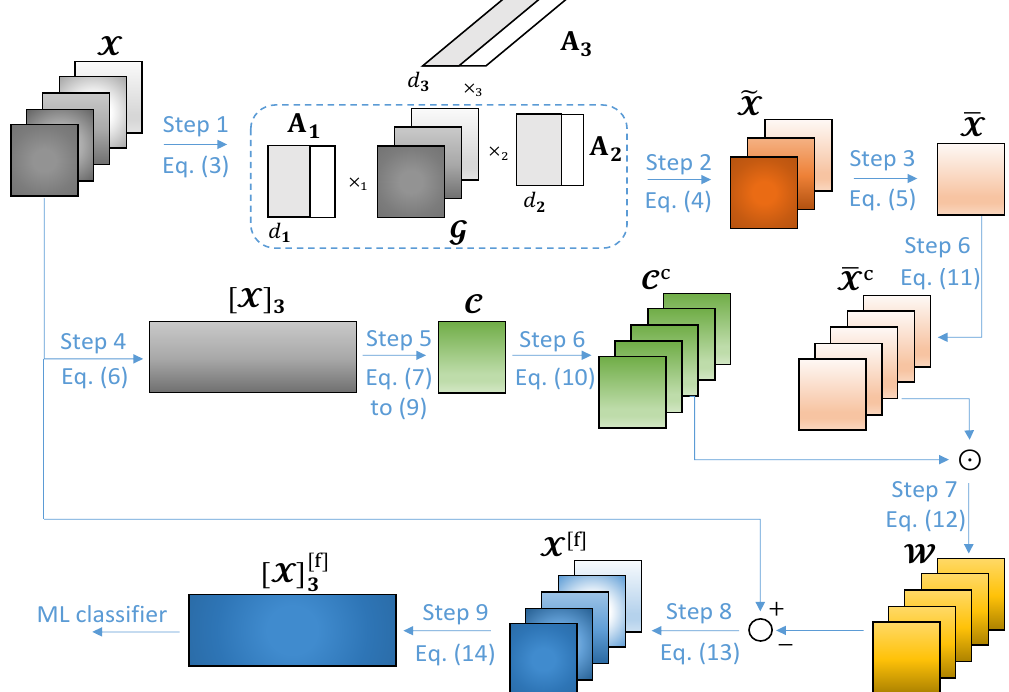
Figure 1. Proposed average common feature extraction technique for DDoS attack detection in Cyber–Physical Systems (CPSs). For simplicity, we depict the filtering process of a three-dimensional dataset tensor XXX ∈ R N 1 × N 2 × M